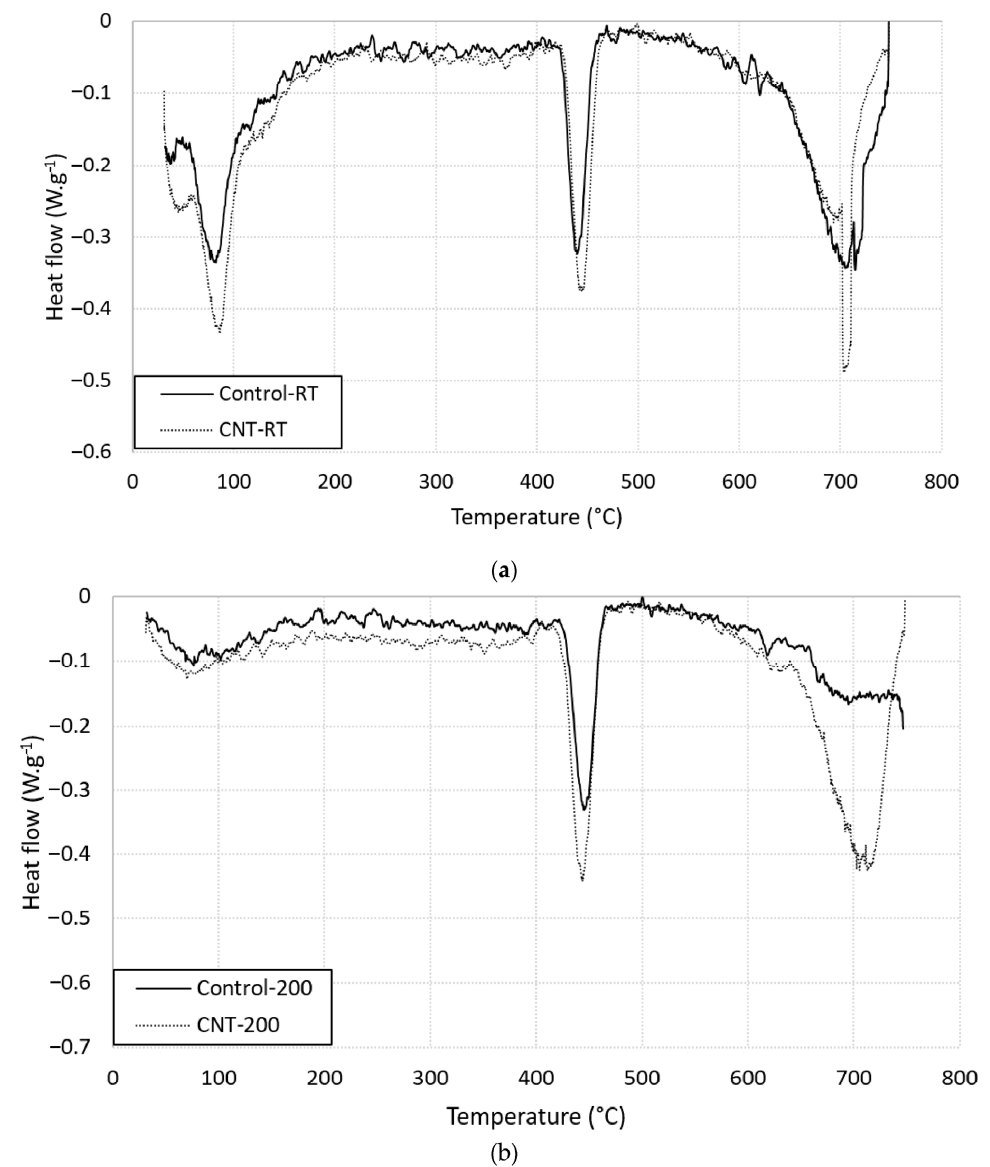
Figure 7. Differential scanning calorimetry (DSC) thermographs for plain and CNT-reinforced mortar ( a ) at room tempera- tures; ( b ) heated at 200 ◦